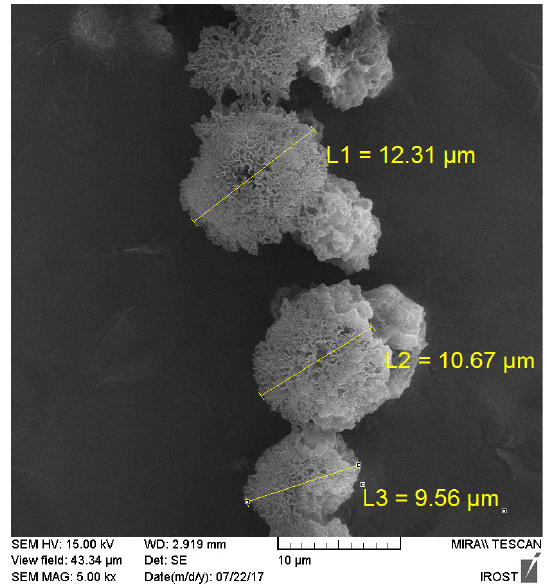
Fig. 2. The SEM image of micronized topiramate.